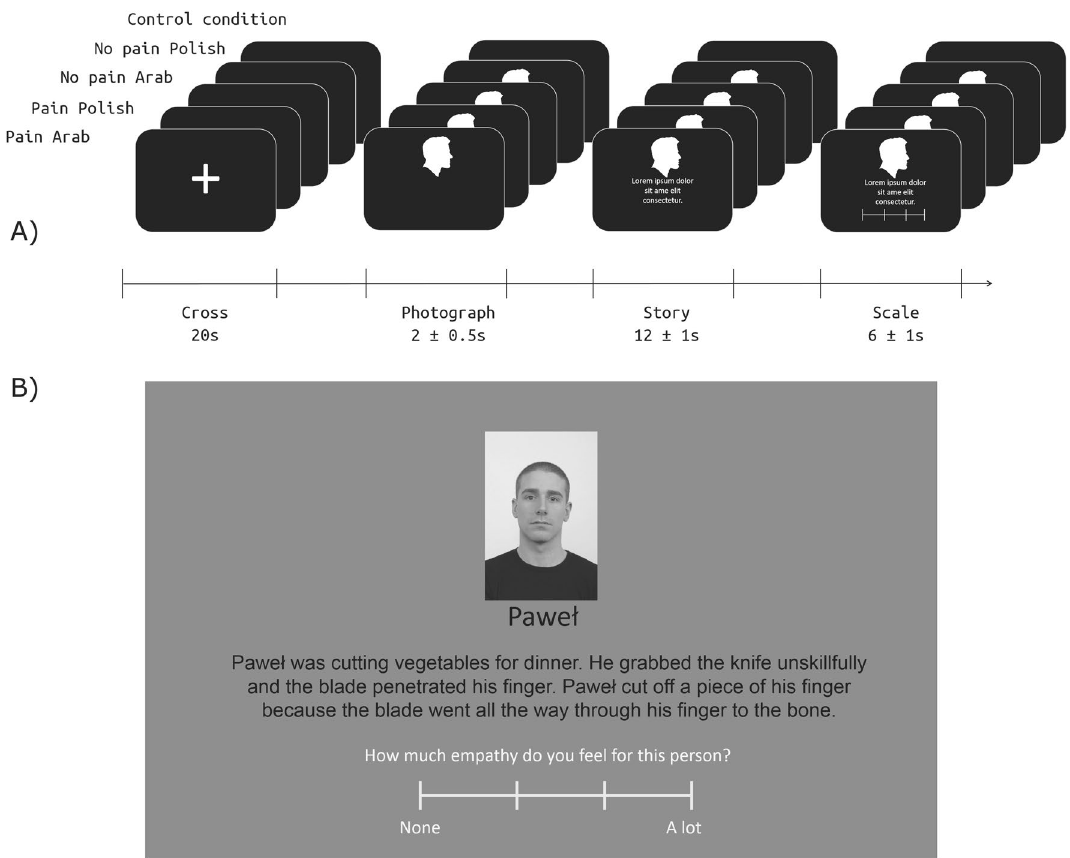
Figure 2. ( A ) A schematic display of the design of the Narrative-based Pain Empathy Task (N-PET) in fMRI. Each experiment condition had the same block structure. In the control condition, the fixation cross was displayed. ( B ) A sample stimulus displayed in the N-PET at the final phase (Scale), when participants were instructed to indicate their empathy towards the